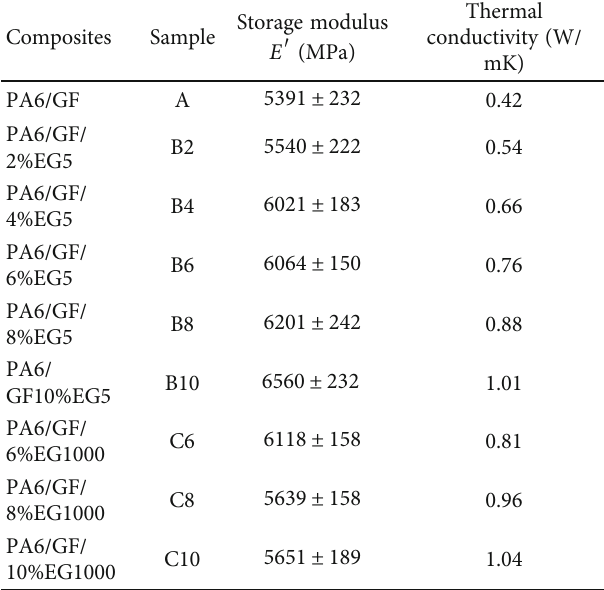
Table 1: Storage modulus determined at 25 ° C and thermal conductivity of glass fi bre-reinforced PA6 composites with the addition of expanded graphite EG5 and